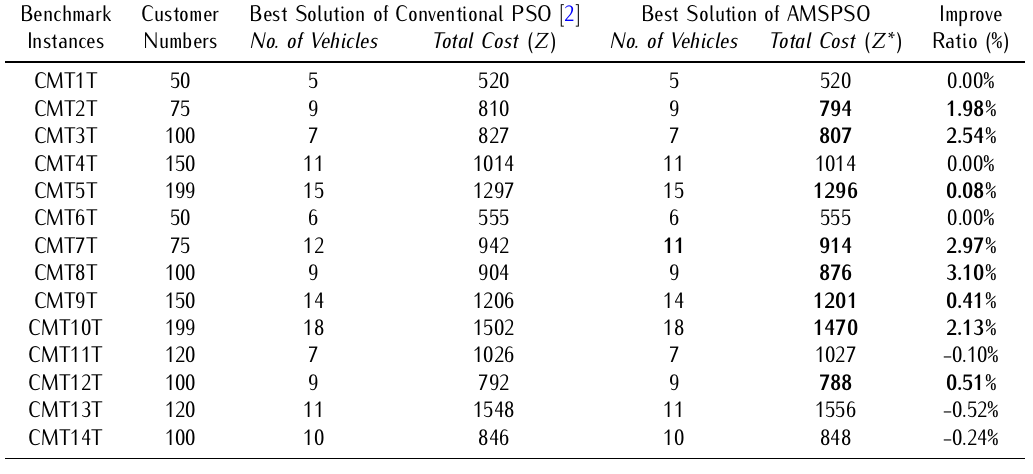
Table 4. Simulation results of CMT n T